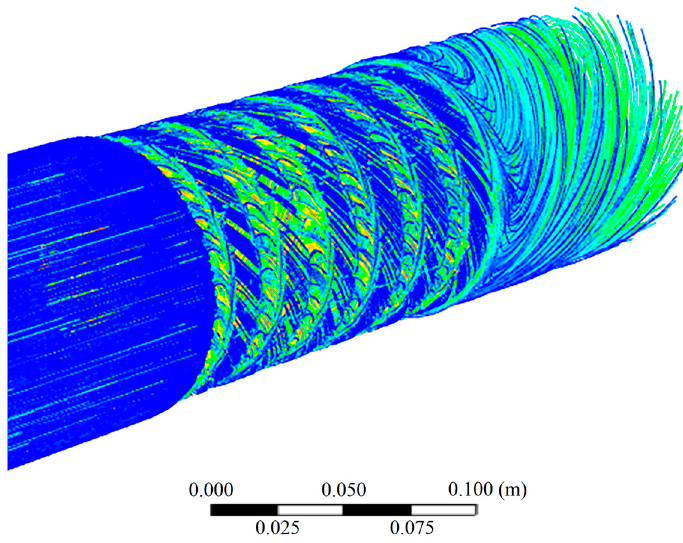
Figure 11. Streamline trajectory of six turbine